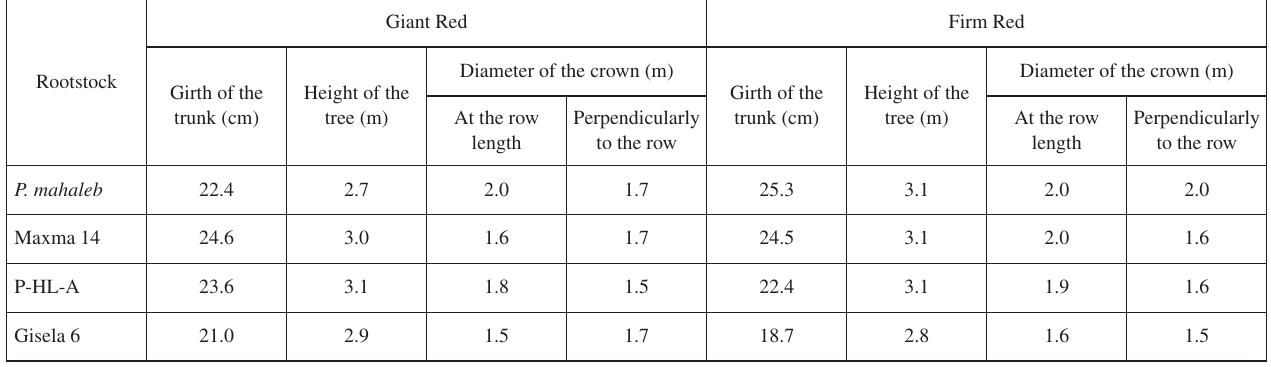
Table 3: Three size of sweet cherry trees grown on different rootstocks (Nagykutas,